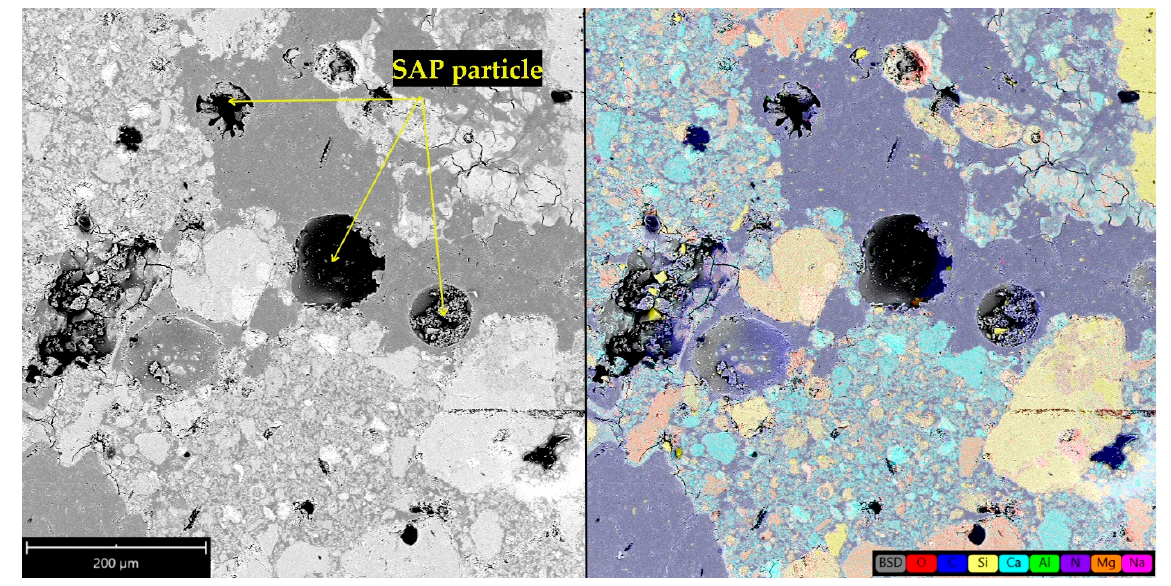
Figure 4. SEM image of the affected zone around the SAP core in hardened A1.5 mixture and element distribution map.